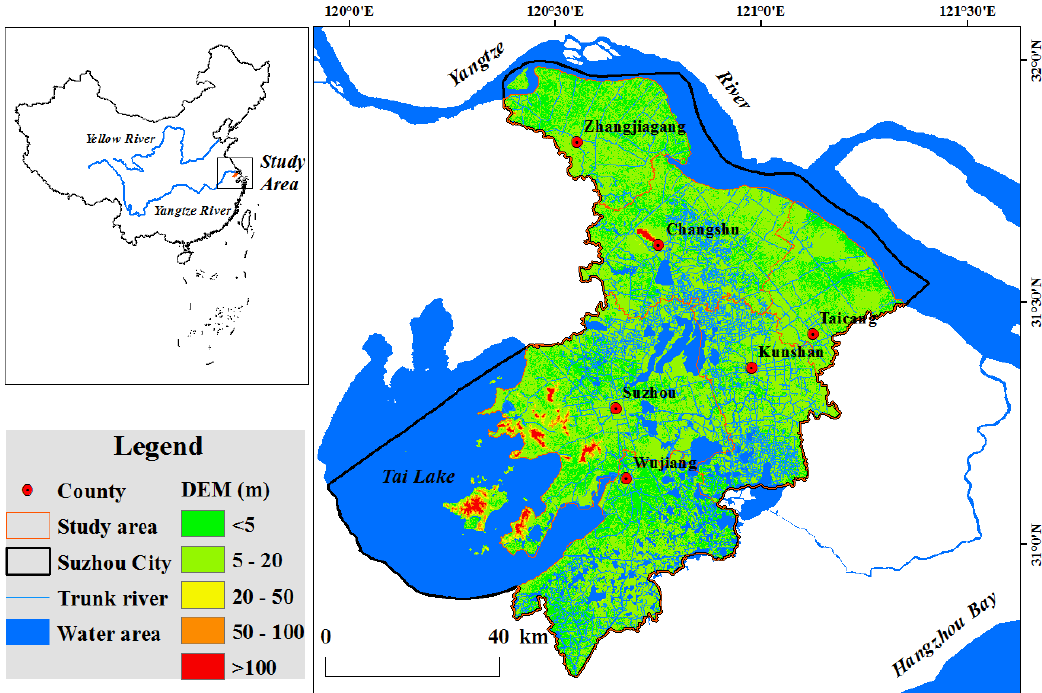
Figure 1. Location of the study area. The trunk river shown in the figure is based on the data of the river systems in the 2010s. In order to represent a dense river system and a low and flat terrain as well, the digital elevation model (DEM) does not cover the trunk river and water area over the study